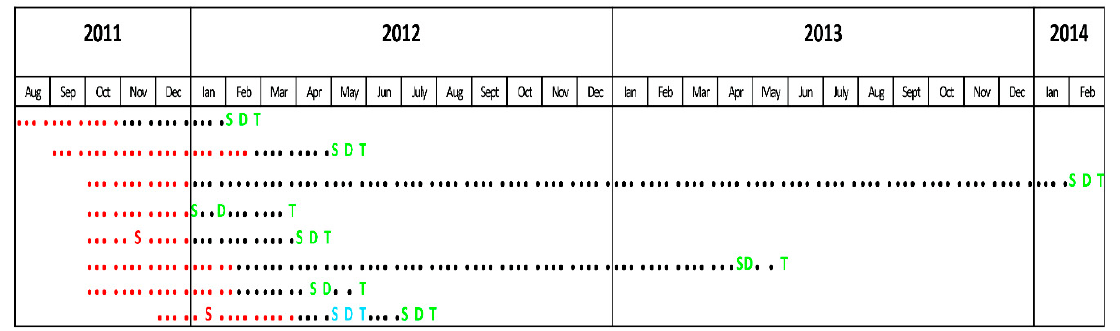
Figure 2. Timeline. Red dots: mission duration. Black dots: time between the return from the endemic region and the events related to P. ovale infection. S: symptoms during mission. S: symptoms due to a P. falciparum attack. S : symptoms due to a P. ovale attack. D: P. falciparum diagnosis. D: P. ovale diagnosis. T: P. falciparum treatment. T: P. ovale treatment (including primaquine eradication